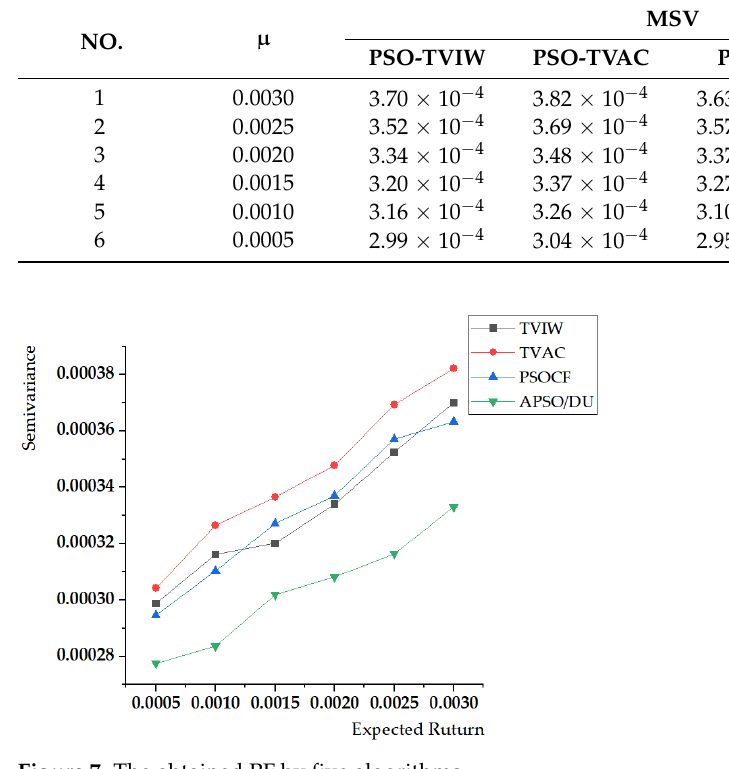
Figure 7. The obtained PF by five algorithms. Table 6. The optimal investment ratio solved by each algorithm at µ =